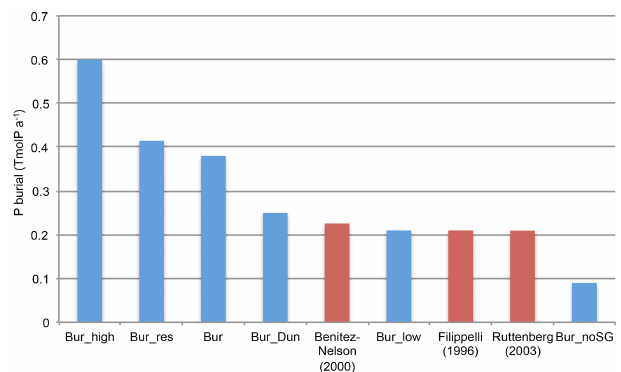
Figure 3. Globally integrated pre-industrial P burial fluxes in TmolPa − 1 from field studies (red) and for UVic model simulations in the year 1775 (blue). Description of the model simulations can be found in Table 1.